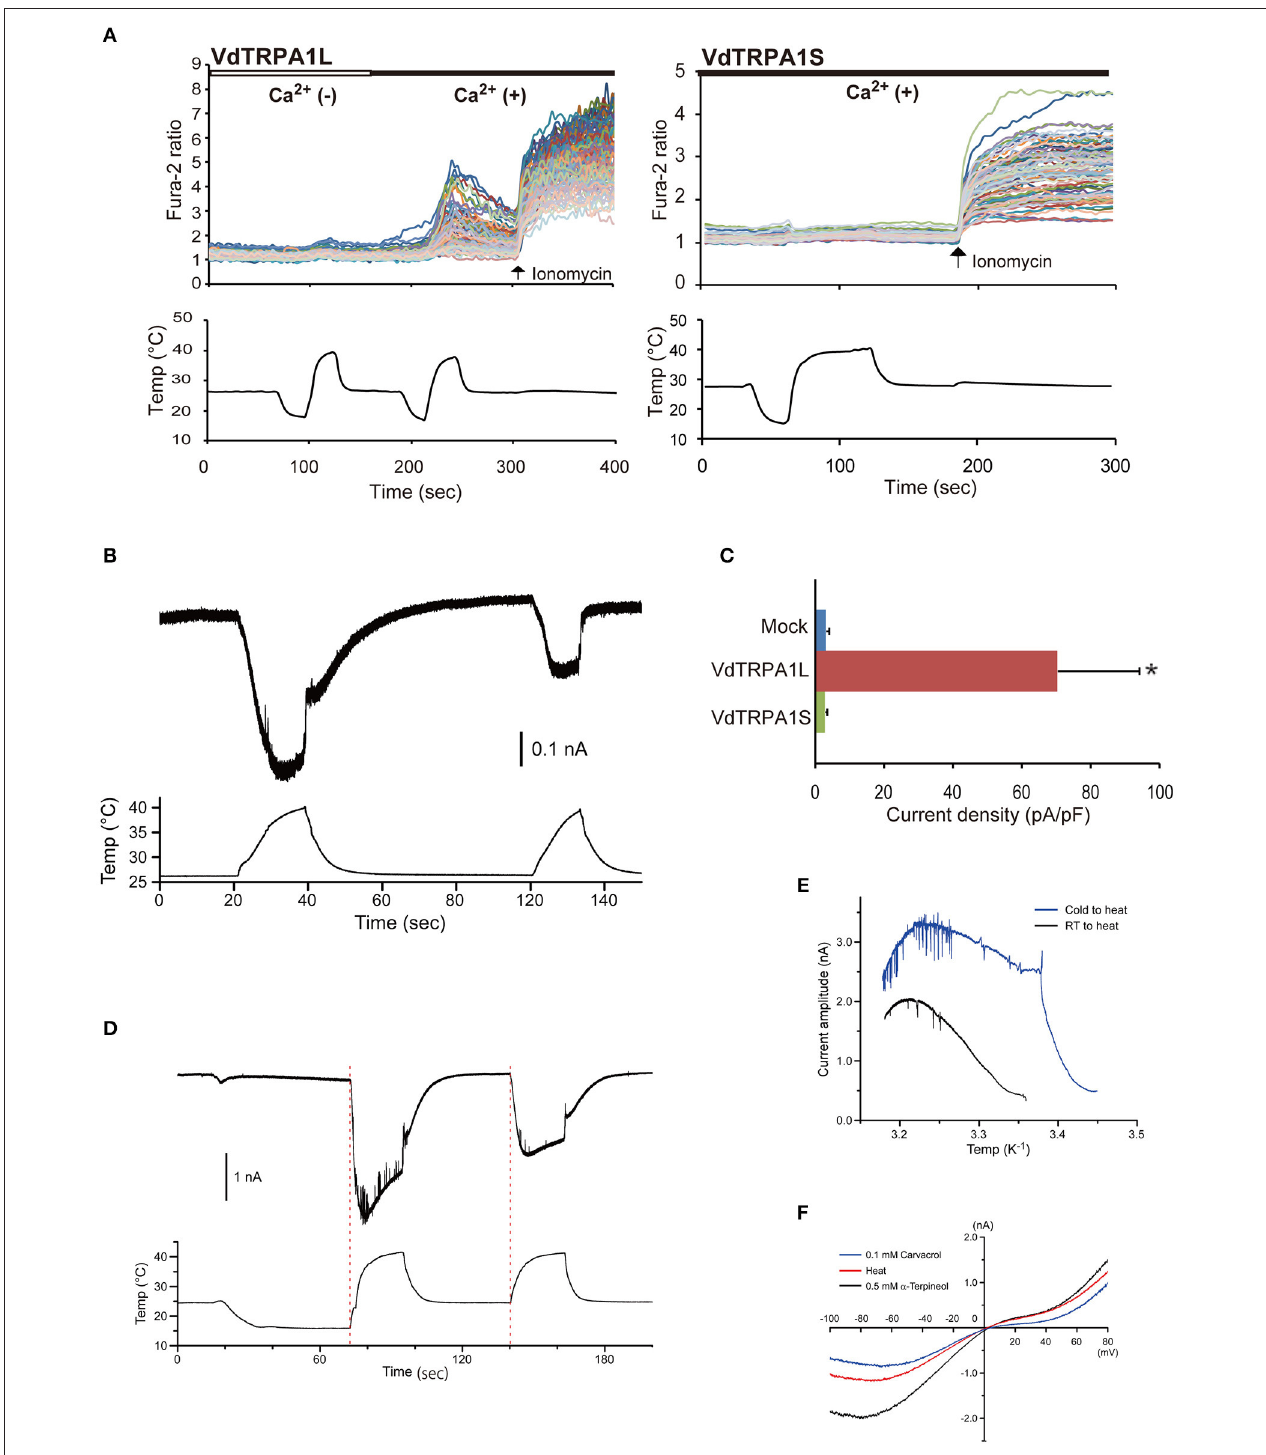
FIGURE 1 | Heat activation profile of VdTRPA1L. (A) The upper traces indicate the changes of intracellular calcium level in VdTRPA1L- and VdTRPA1S-expressing cells (84 and 54 DsRed-positive cells on one cover glass, respectively) on temperature fluctuation in the absence [white bar, Ca 2 + ( − )] or presence [black bar, Ca 2 + ( + )] of extracellular calcium. Each line represents the intracellular calcium level in the individual cell measured by calcium imaging. The arrows show the time points when 5 µ M ionomycin was added. The lower traces show the changes of bath temperature by time (sec, second). (B) Heat activation of VdTRPA1L analyzed by whole-cell patch clamp recording. (C) Heat-activated current density of mock-transfected cells, VdTRPA1L-, and VdTRPA1S-expressing cells measured by patch-clamp